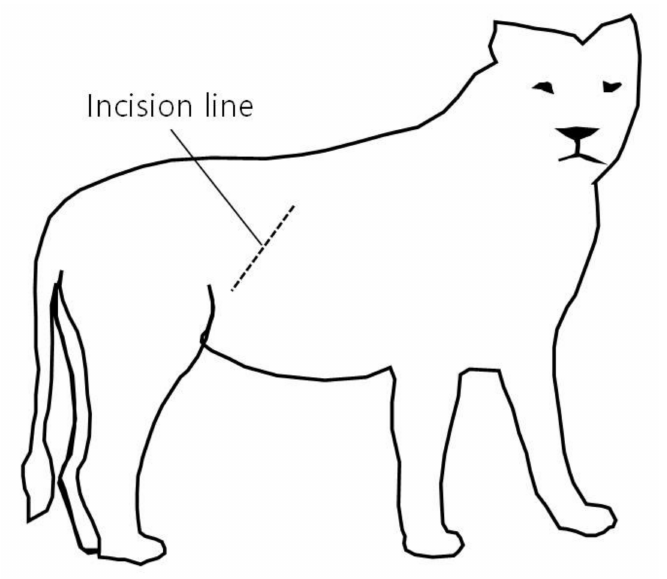
Figure 2. Skin incision line for pyometra surgery in a lion ( Panthera leo ). A right lateral flank laparotomy was performed via an approximately 20 cm incision from 5 cm below the 3rd lumbar transverse process towards the knee joint.